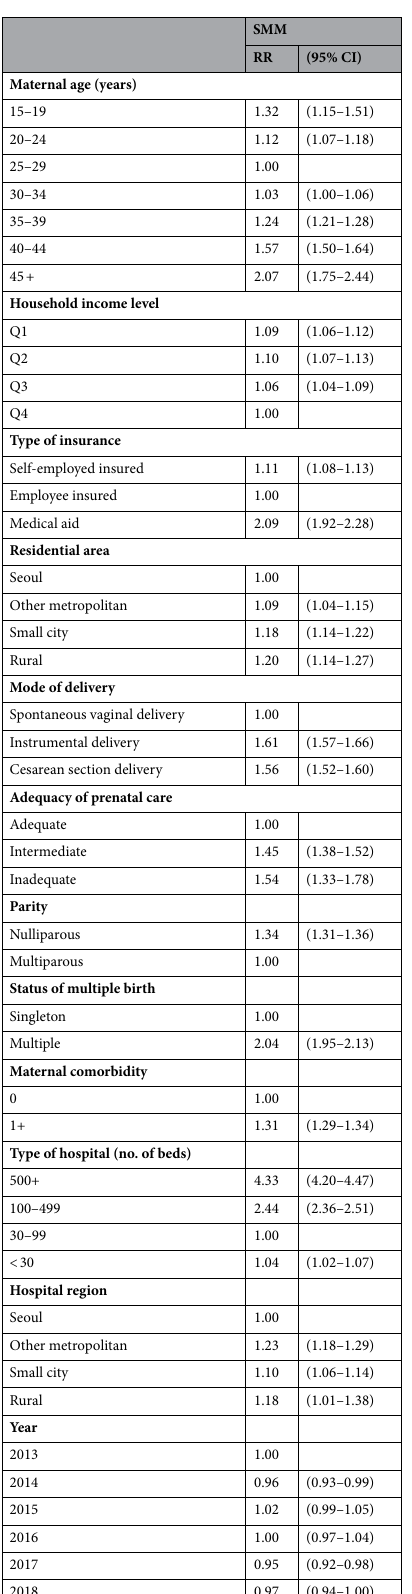
Table 2. Relative risk for the relationship between maternal age and SMM adjusted for all covariates. Adjusted for household income level, type of insurance, residential area, mode of delivery, adequacy of prenatal care, parity, status of multiple birth, maternal comorbidity, type of hospital, hospital region, and